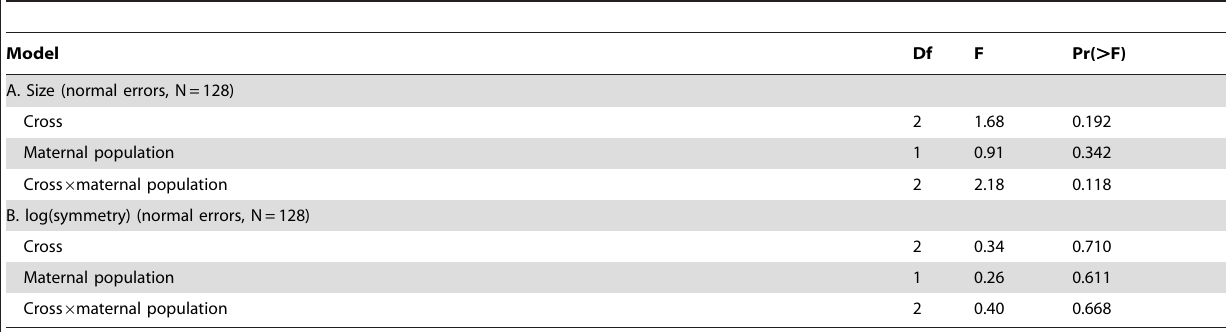
Table 3. Generalized linear models for (A) body size and (B) symmetry.